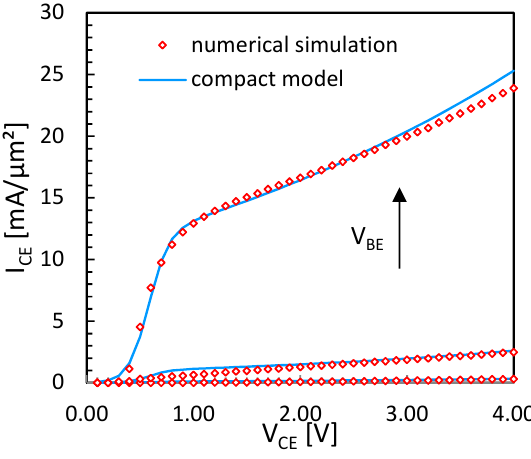
Figure 6. g M versus I C curves for different V CB (2, 3, 4, 5 V) simulated with the numerical model and the compact model.